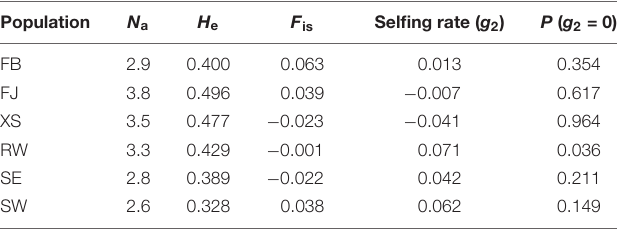
N a number of alleles, H e expected heterozygosity, F is inbreeding coefficient, Selfing rate (g 2 ) indicates selfing rate estimated from g 2 in inbreedR package, P (g 2 = 0) the probability value for g 2 = 0.